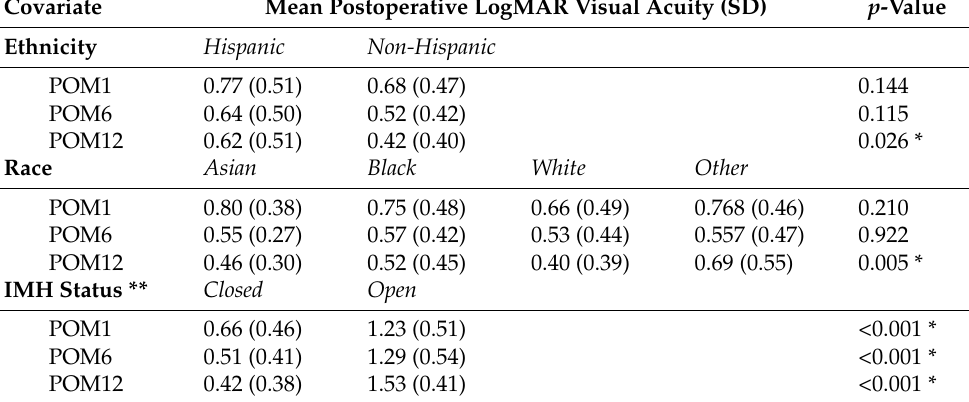
Table 8. Mean preoperative logMAR VA of the study eyes categorized by ethnicity, race, and IMH closure status.